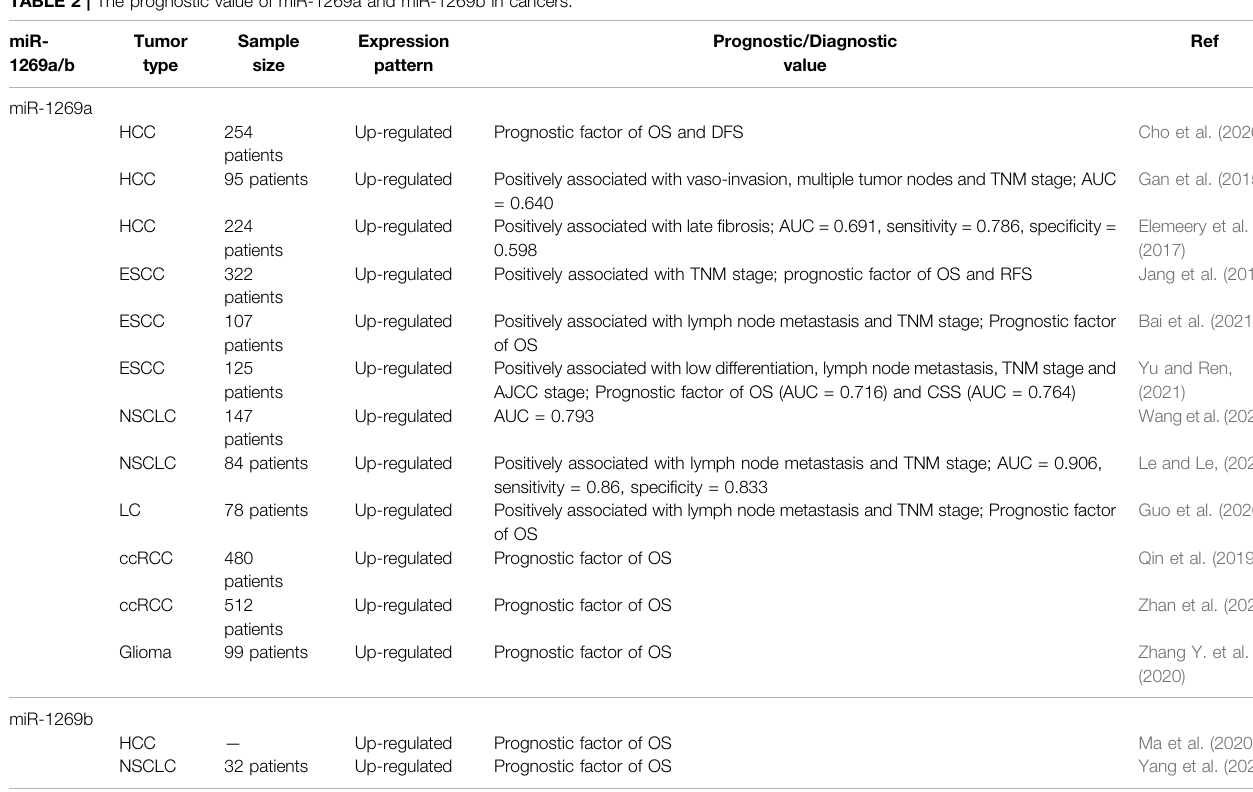
TABLE 2 | The prognostic value of miR-1269a and miR-1269b in cancers. miR-